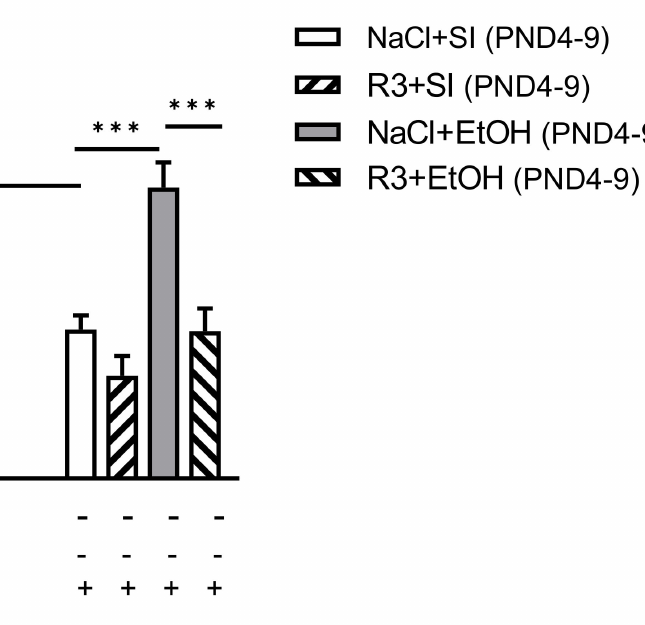
Figure 5. The influence of rapamycin pre-treatment (3 mg/kg, i.p.) during neonatal period before every ethanol administra- tion on the development of CPP induced by ethanol (1.0 g/kg; 1.5 g/kg) in adult male rats (PND60–70). Data are shown as post-conditioning minus pre-conditioning time (sec) spent in the drug-associated compartment. Results are expressed as mean ± SEM of 8 subjects per group (GraphPad version 8.0 for Windows). * p < 0.05 ** p < 0.01; *** p < 0.001. R3–rapamycin 3 mg/kg; SI–shame intubation (i.g.); EtOH–ethanol intubation